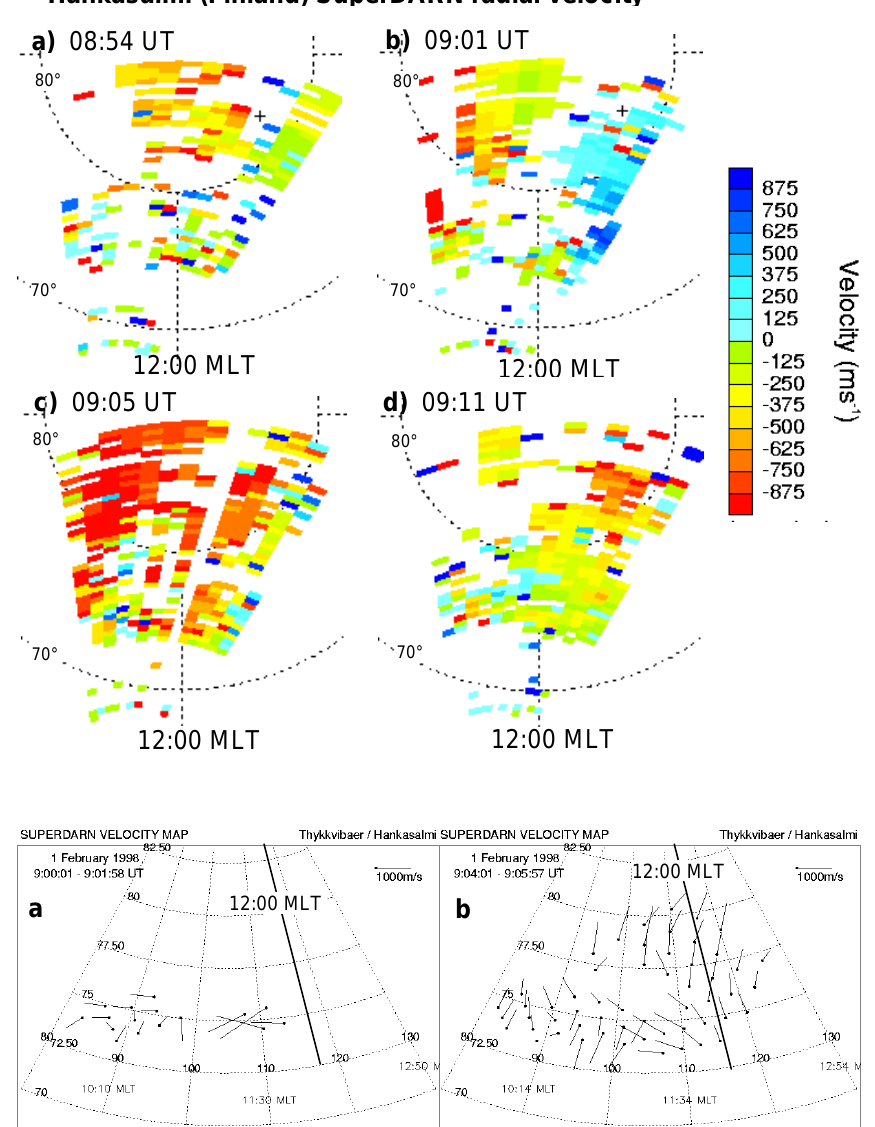
Fig. 7. Vector velocity map deduced from the Cutlass radar pair. (a) During the preliminary impulse; (b) during the main impulse. The thick line shows the 12:00MLT meridian at